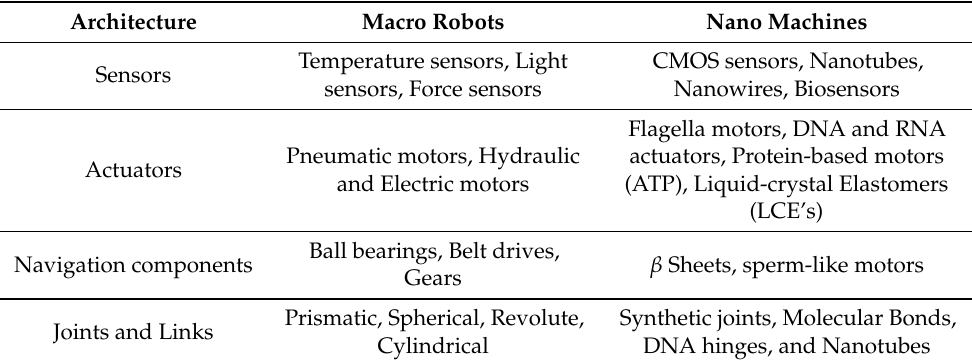
Figure 1. Basic architecture of a nanorobotic system. Table 1. Comparison between the architecture of macro robots and